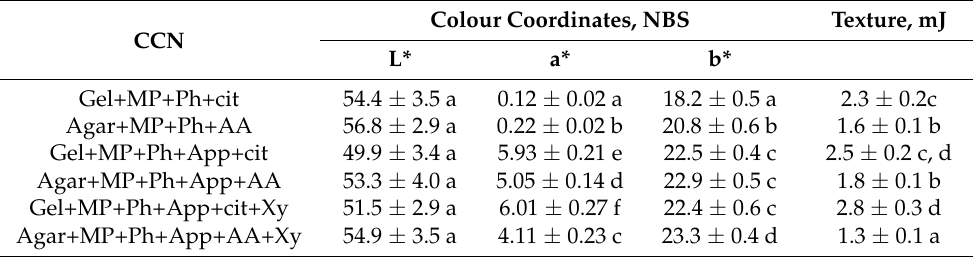
Table 4. Colour coordinates and texture parameters of the prepared